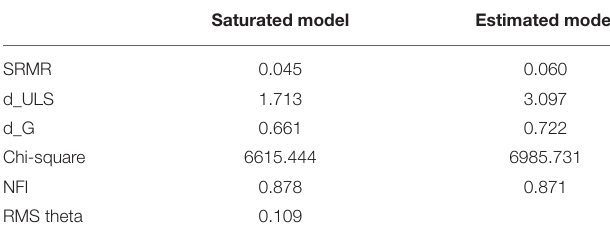
TABLE 11 | Goodness of fit—structural/inner